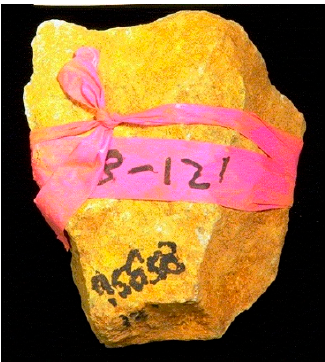
Figure 1. One of the rocks from the sections of the Gibraltar leaching dump.